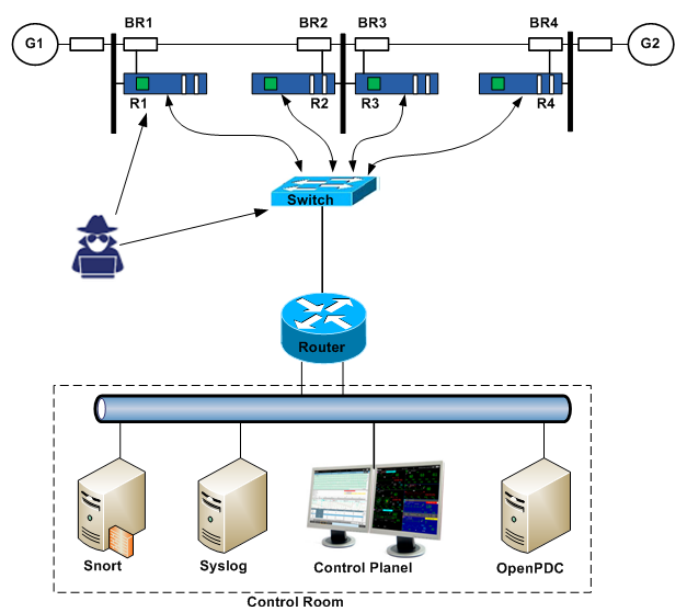
Figure 6. Case study: industrial control power system